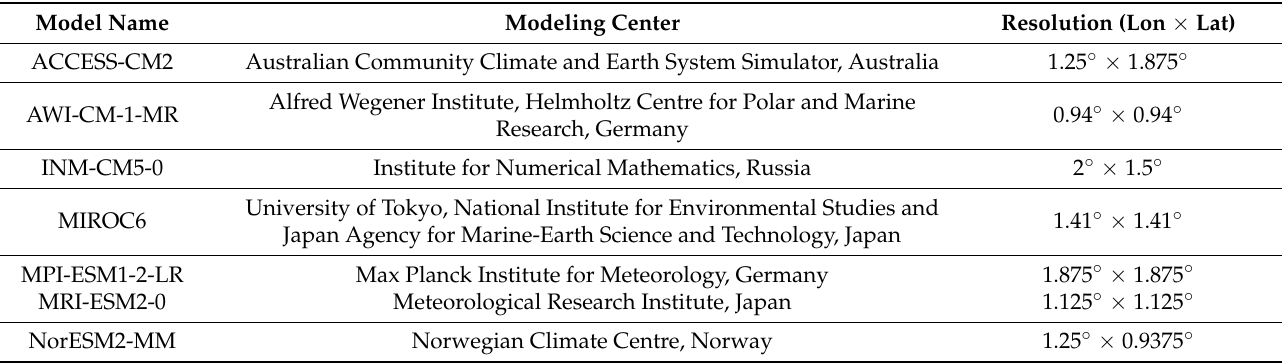
Table 1. List of CMIP6 models used for MME approaches: SD and EM.